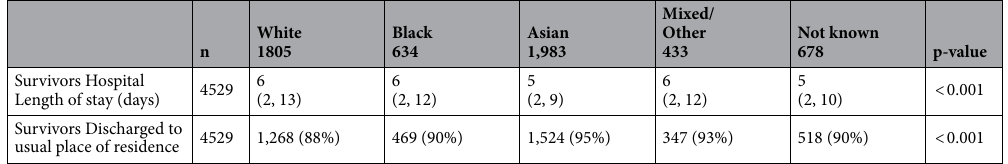
Table 1. Characteristics of 5533 patients with COVID-19 associated first hospital admissions during second pandemic wave between 1/9/20 and 17/2/21.